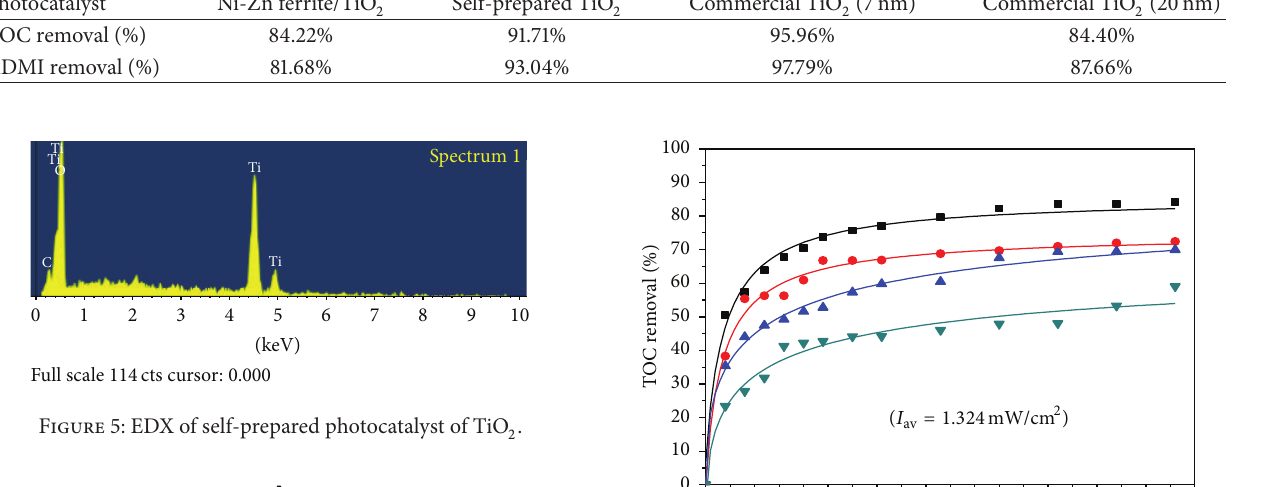
= 1.324 W/cm 2 ). av